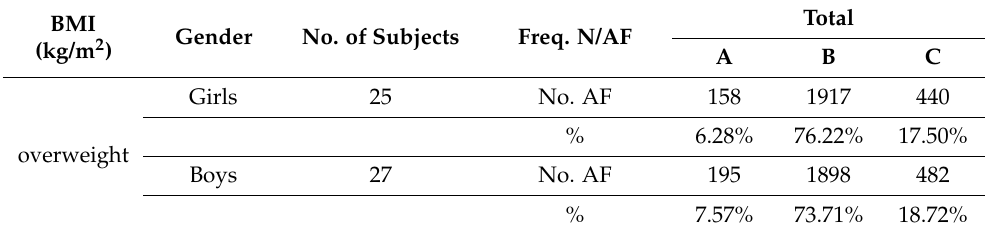
Table 7. Total number of performed physical activities by gender, weight group, and intensity of the physical